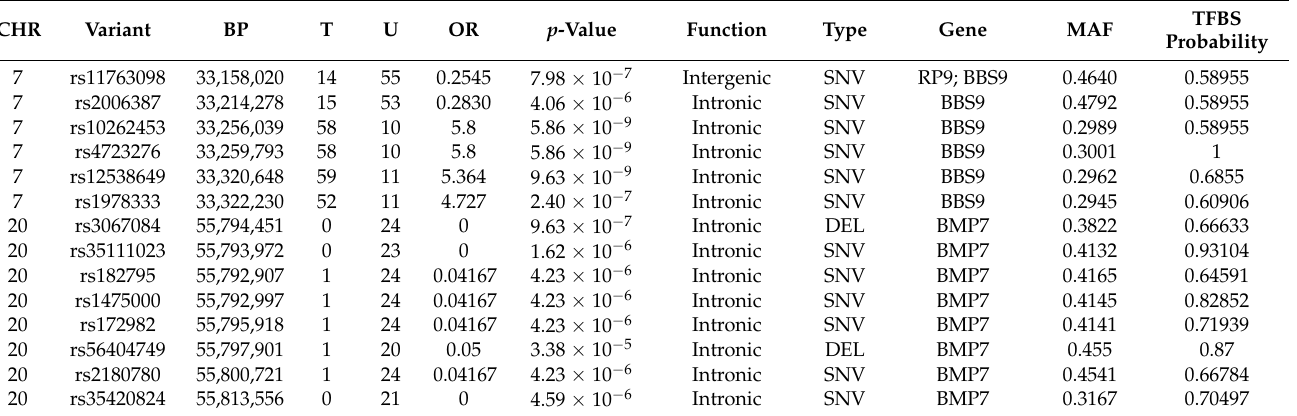
Table 3. Selected potential causal variants in chromosome 7 and 20 target regions from mNCS leave- one-out analysis.